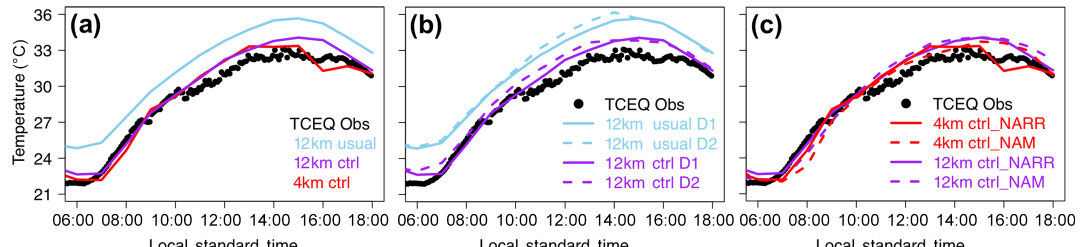
Figure 4. Comparing NUWRF daytime surface air temperature with the 5min TCEQ surface in situ measurements (black dots) at Conroe, TX, on 11 September 2013: (a) evaluating the impact of NUWRF land initialization and grid resolution; (b) evaluating the impact of NUWRF simulation length, including 1-day (D1) and 2-day (D2) forecasts, on the 12km grid; and (c) evaluating the impact of NUWRF atmospheric initialization (using NARR and NAM) on 12 and 4km grids. Control is denoted by ctrl.